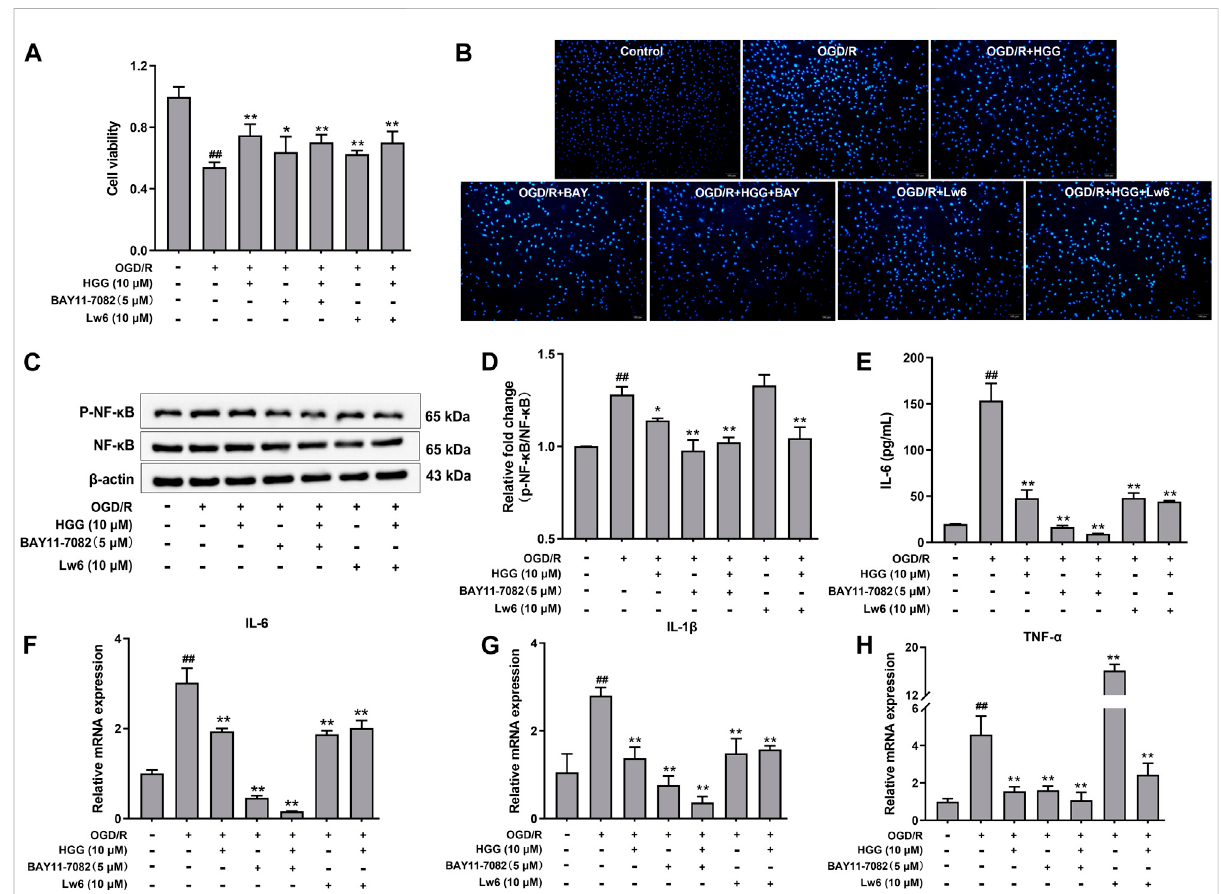
FIGURE 7 Effects of Lw6 (a HIF-1 α inhibitor) and BAY11-7082 (a NF κ B inhibitor) on OGD/R induced in fl ammation in HUVECs. The cell viability, expression ofpro-in fl ammatorycytokines,andWesternblotanalysisofOGD/R-treatedHUVECsinthepresenceorabsenceofHGG. (A) CellviabilityofHUVECs determined by MTT assay. (B) Apoptosis assay with hochest-33342 staining, Scale bar = 100 μ m. (C) The protein expression levels of p-NF- κ B and NF- κ B were determined using Western blot analysis. (D) The relative expression of p-NF- κ B/NF- κ B in HUVECs after OGD/R. (E)